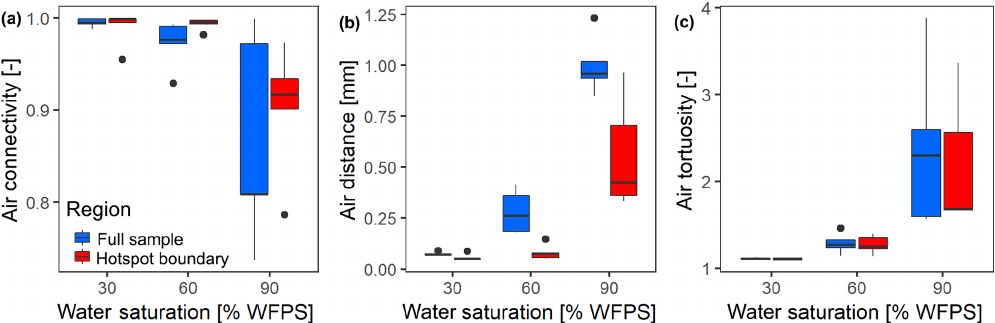
Figure 6. Morphological properties of air-filled pores at different saturations averaged over different hotspot architectures ( n = 5). These properties are reported separately for the entire pore space within the region of interest (full sample) and for the pore space in direct vicinity to the porous glass beads (hotspot boundary): (a) air connectivity represents the volume fraction of air with direct connection to the headspace. (b) Air tortuosity represents the ratio between geodesic length to the headspace and Euclidean distance for any voxel within the connected air- cluster. (c) Air distance represents the geodesic distance to the connected air cluster within the water-filled pores. Data shown as box–whisker plots: whiskers – min and max; middle lines – median; dots – outliers.